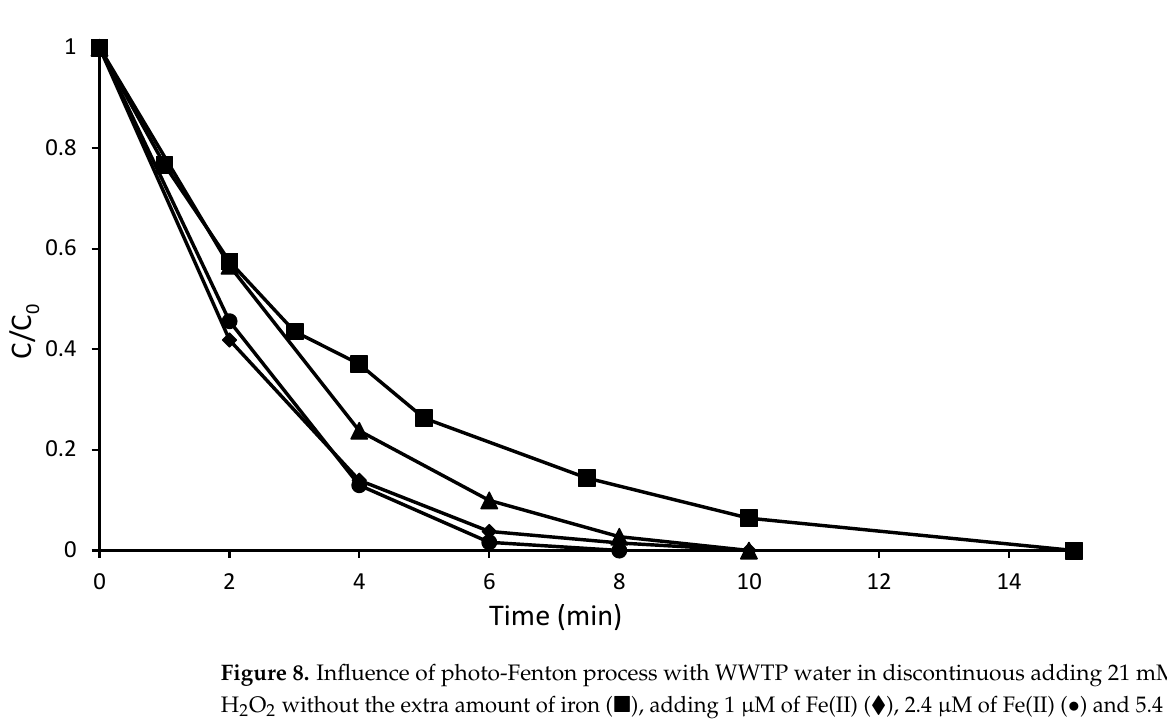
Figure 8. Influence of photo-Fenton process with WWTP water in discontinuous adding 21 mM of H 2 O 2 without the extra amount of iron ( (cid:4) ), adding 1 µ M of Fe(II) ( (cid:7) ), 2.4 µ M of Fe(II) ( • ) and 5.4 µ M of Fe(II) ( (cid:78) ).